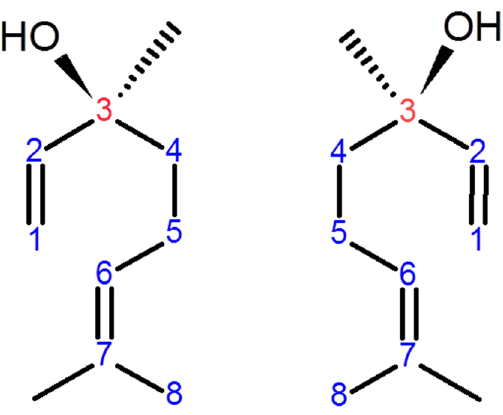
Figure 1. The stereo-configuration of linalool. ( S )-( + )-linalool or coriandrol ( left ) and ( R )-(–)-linalool or licareol ( right ). The enantiomeric properties of linalool are due to the chiral carbon number 3 (red- colored).